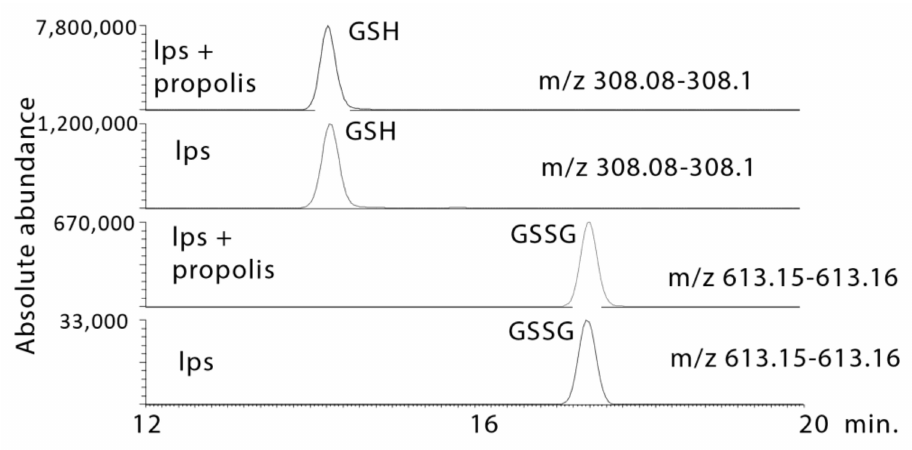
Figure 12. Extracted ion traces showing increased in GSH and oxidised glutathione (GSSG) in LPS-stimulated macrophages treated with